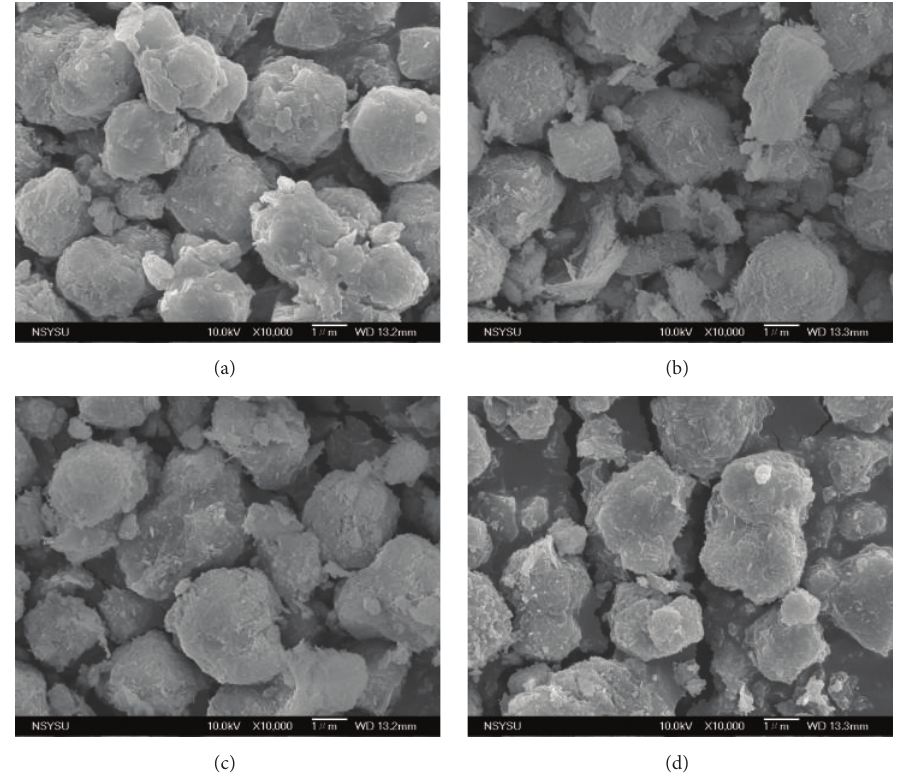
Figure 5: SEM images of NaX and 0.1-NaCoX thermally treated zeolites: NaX sample (a) and the samples treated at 400 ∘ C for 3 h (b), 600 ∘ C for 3 h (c), and 700 ∘ C for 3 h (d).